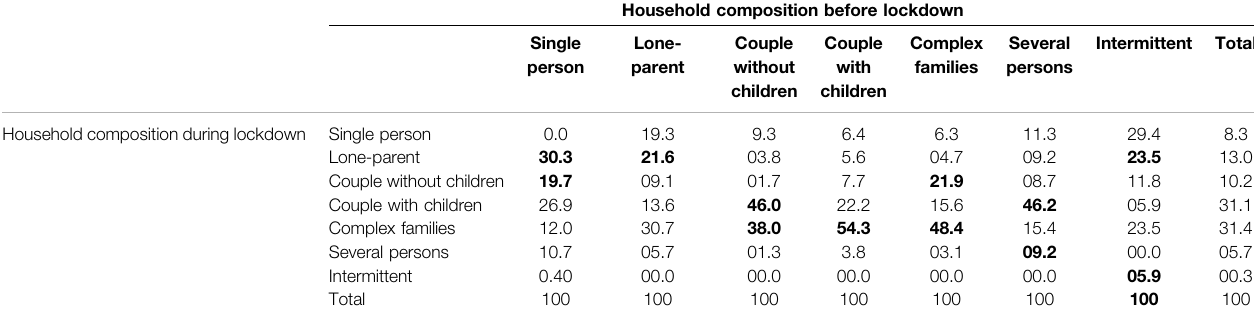
TABLE 7 | Distribution of household types that changed during lockdown (in